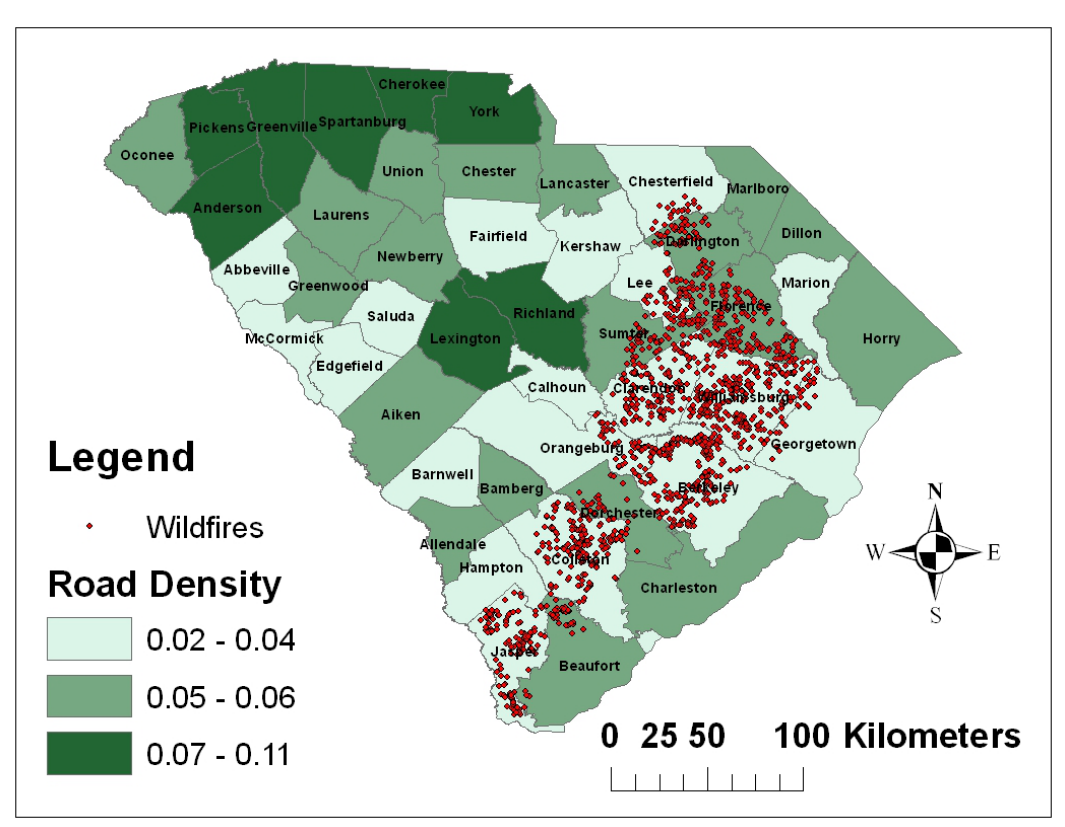
Figure 12. Road density per square km by